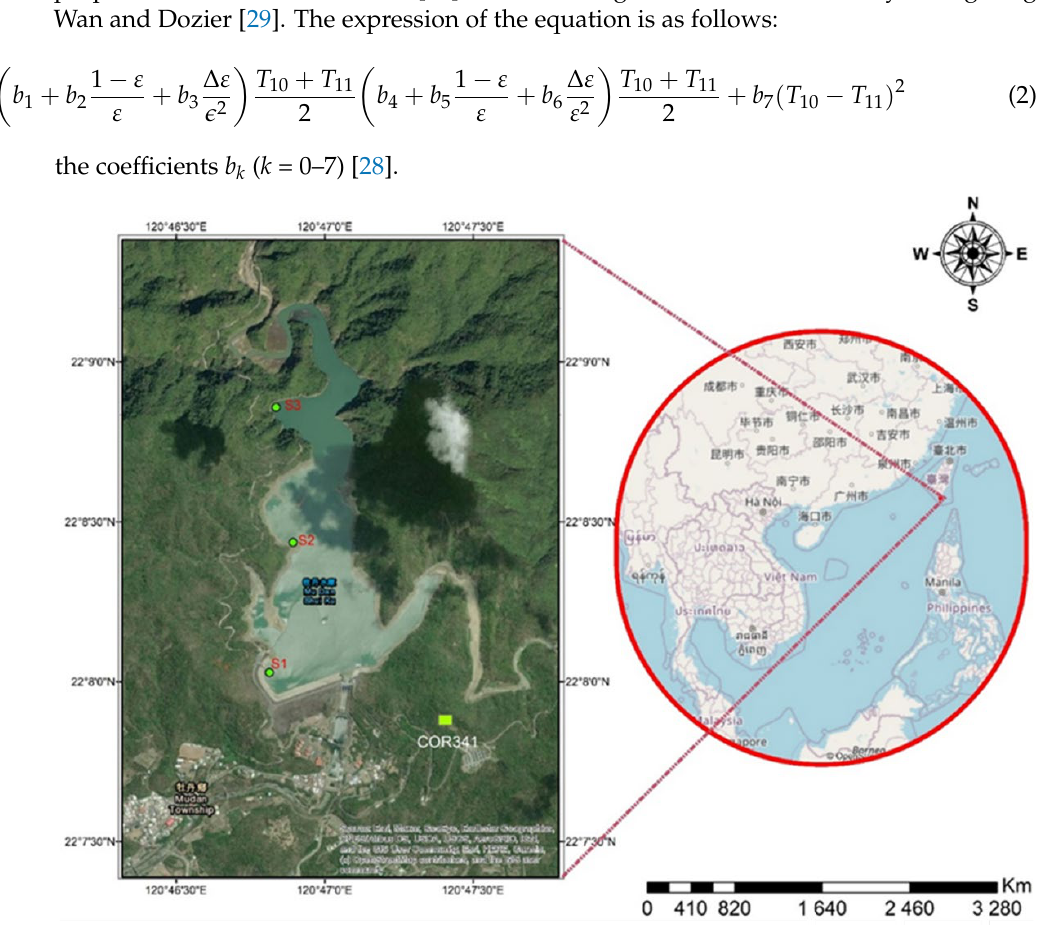
Figure 1. Location of Mundan water reservoir and Mundan meteorological station (COR 341) with respect to the map of Taiwan, the reservoir is showing the sampling points S1–S3 as indicated on the map (left-side).